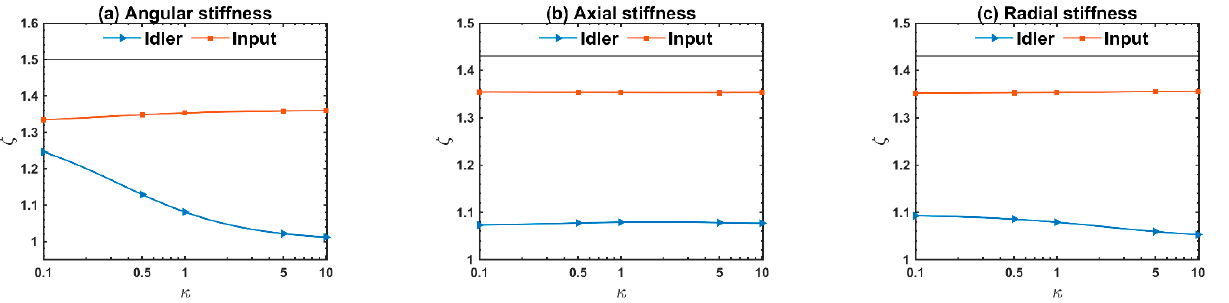
Figure 13. Influence of the angular, axial, and radial stiffness of the upper face gear on the load sharing